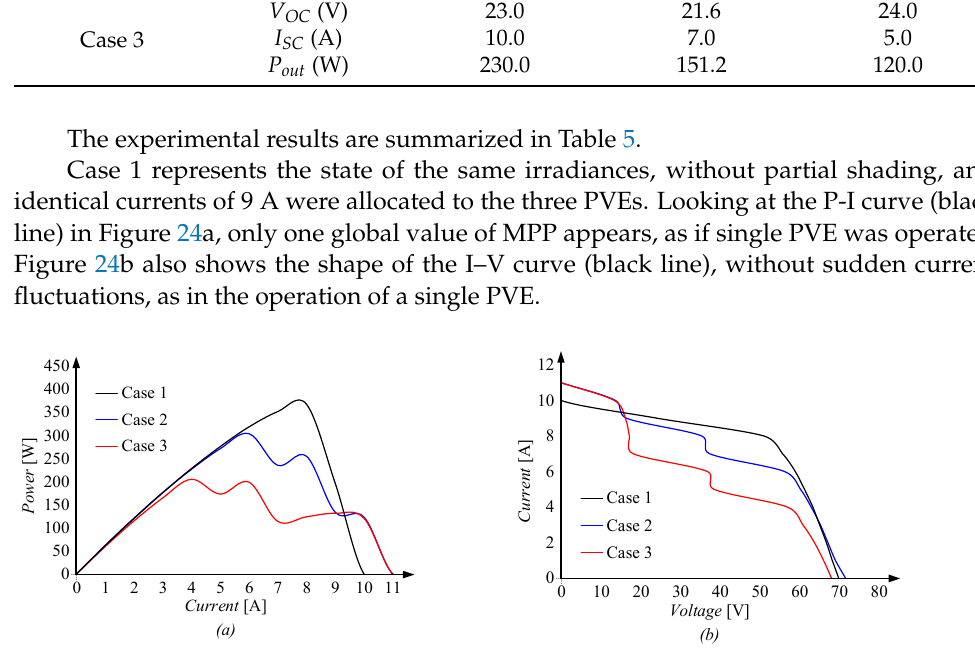
Figure 24. Experiment results of multiple series connections of PVEs for Case 1, 2, and 3: ( a ) P–I curve; ( b ) I–V curve.